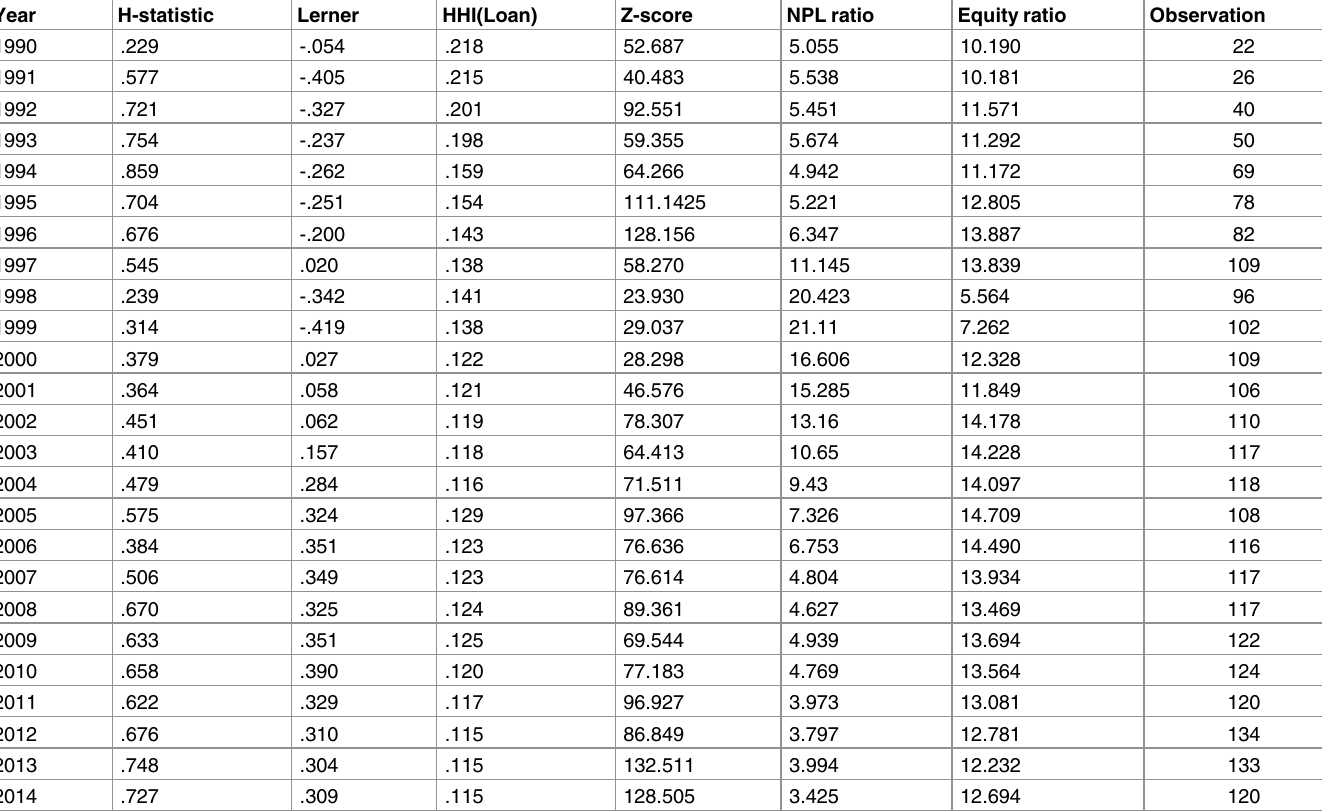
Table 2. Yearly averageof H-statistic, Lerner index, and HHI based on loan based on loan for ASEAN-5 during 1990–2014. Year Lerner